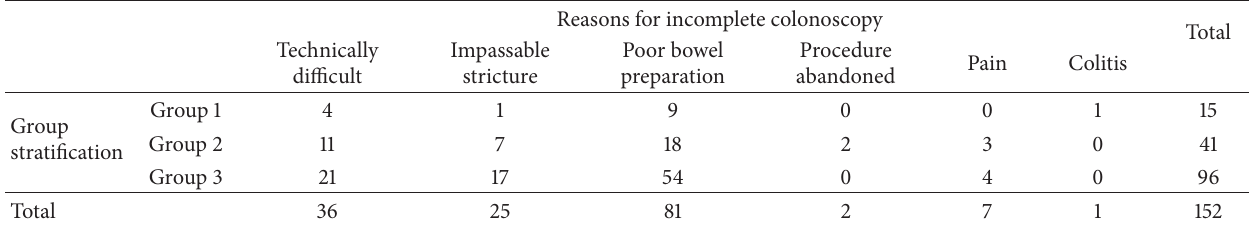
Table 3: Reasons for incomplete colonoscopy, according to risk group.